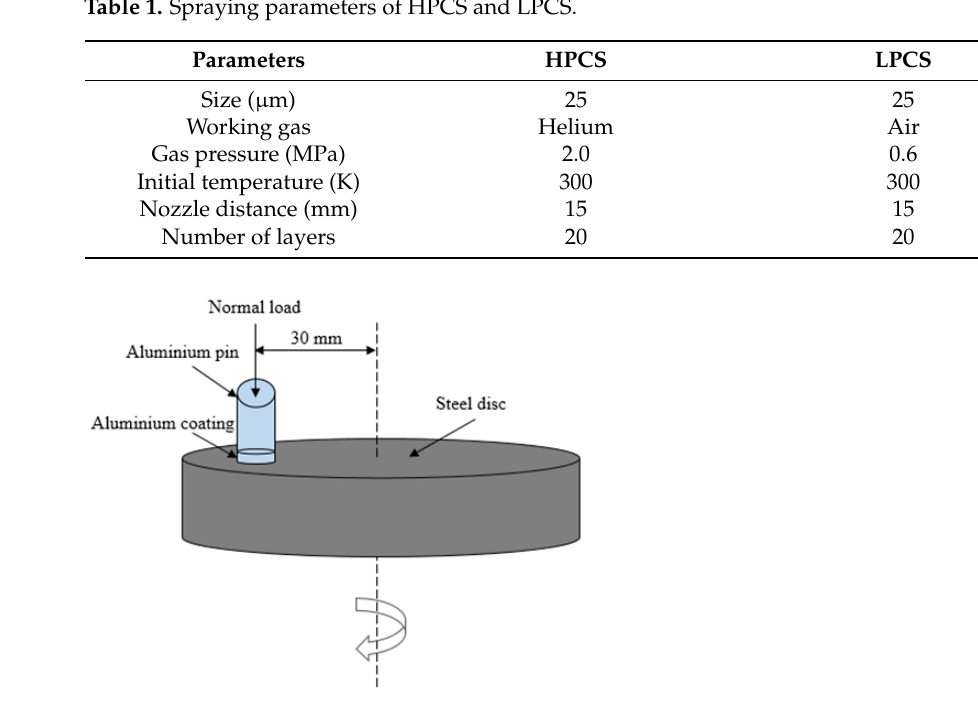
Figure 2. Schematic diagram of micro pin-on-disc tribotester. Table 2. Wear-test